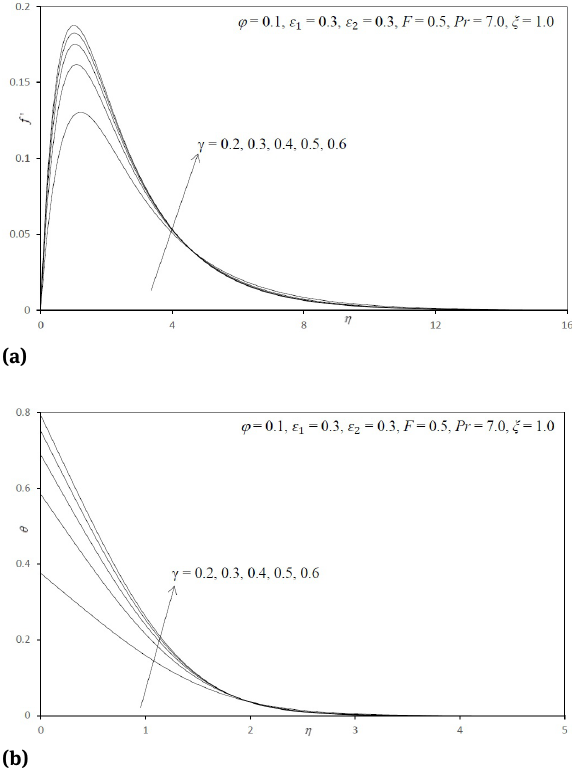
Fig. 6: (a) Effect of γ on Velocity Profiles; (b) Effect of γ on Tempera- ture